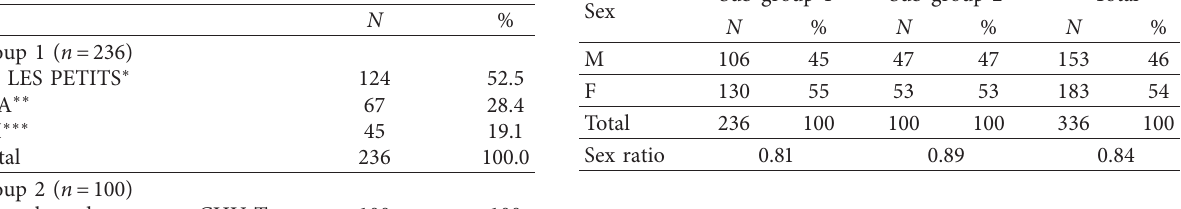
Table 3: Distribution of the study population by